Question: Describe this figure in one sentence.
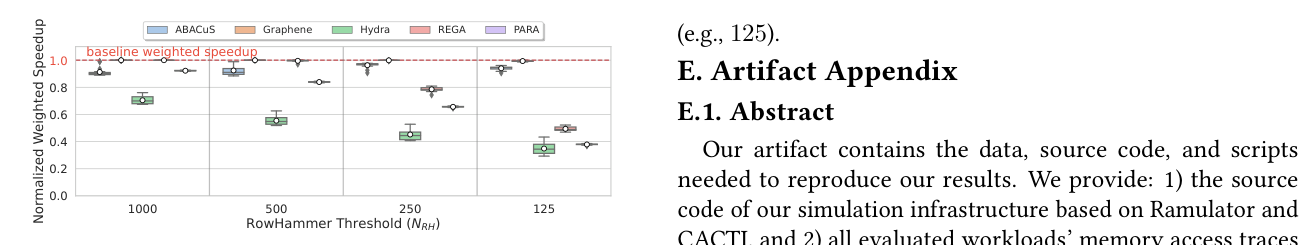
Answer: Normalized performance (distribution) of heteroge- neous 8-core applications with varying RowHammer Thresh- old for ABACuS and four state-of-the-art mechanisms.